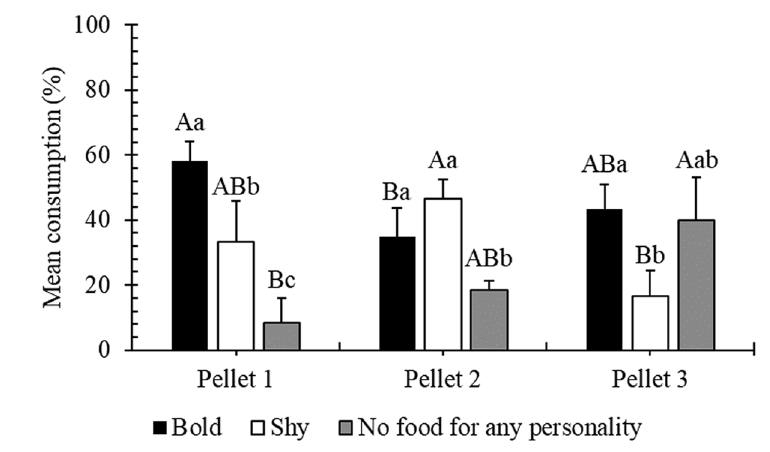
Figure 2. Mean values (± standard deviation) for consumption percentage of each pellet by Nile tilapia ( Oreochromis niloticus ) of different personalities. Different uppercase letters indicate significant difference in consumption among pellets for each personality between the different pellets. Lowercase letters indicate significant difference in consumption between personalities for each pellet. The results were submitted to ANOVA followed by the Tukey test ( p <